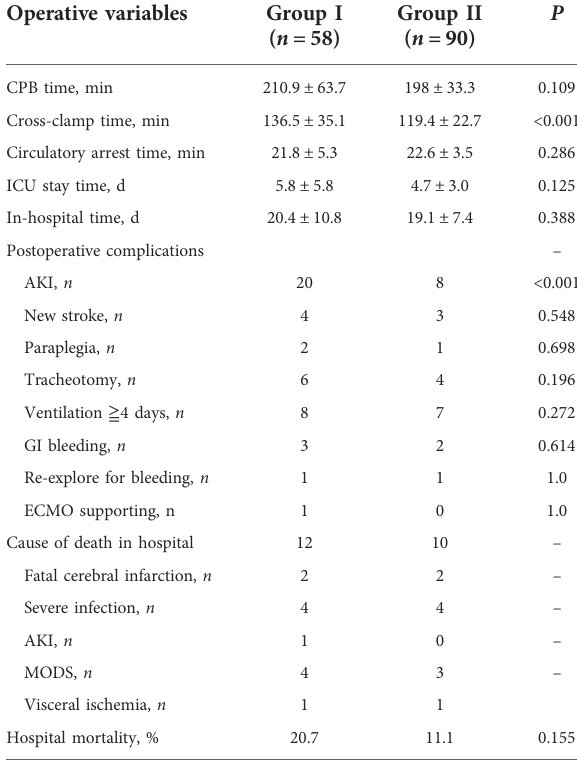
TABLE 3 The overview of surgical